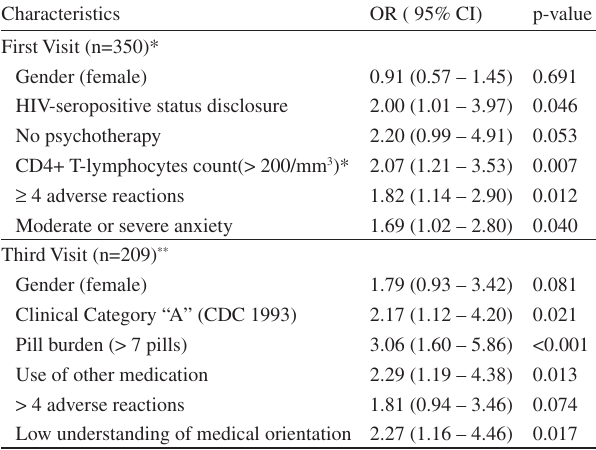
Table 4 - Final multivariate analysis of the degree of difficulty in the first and third visits, ATAR Project, 2001-2003